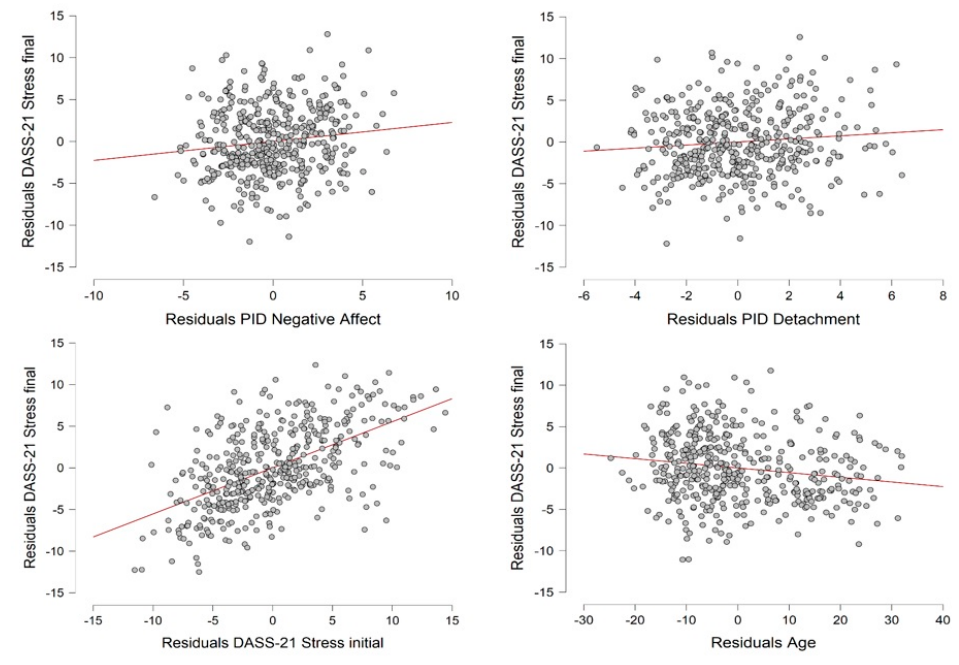
Figure 3. Partial regression plots representing the relationship between the DASS-21 Stress subscale score during the final period of the lockdown and the independent variables that accounted for a significant proportion of the variance according to the linear regression